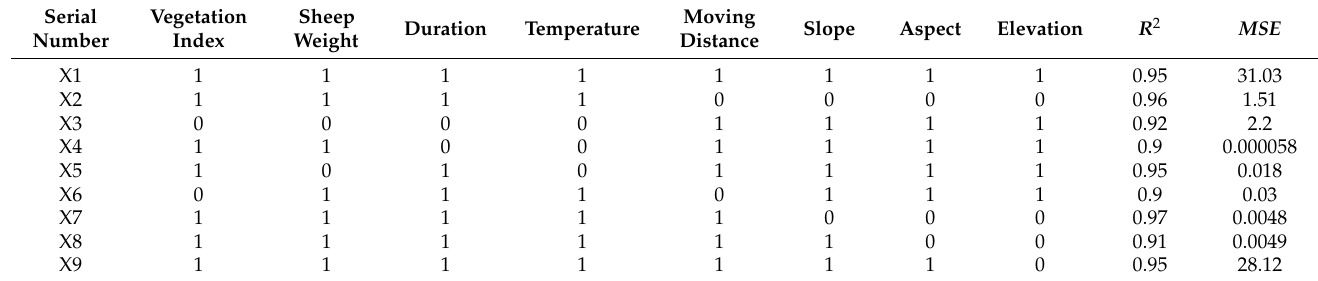
Table 1. Collocation of